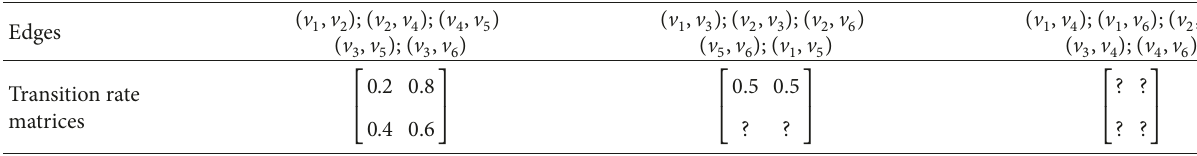
Table 2: Transition rate matrices of the Markov chains in graph.